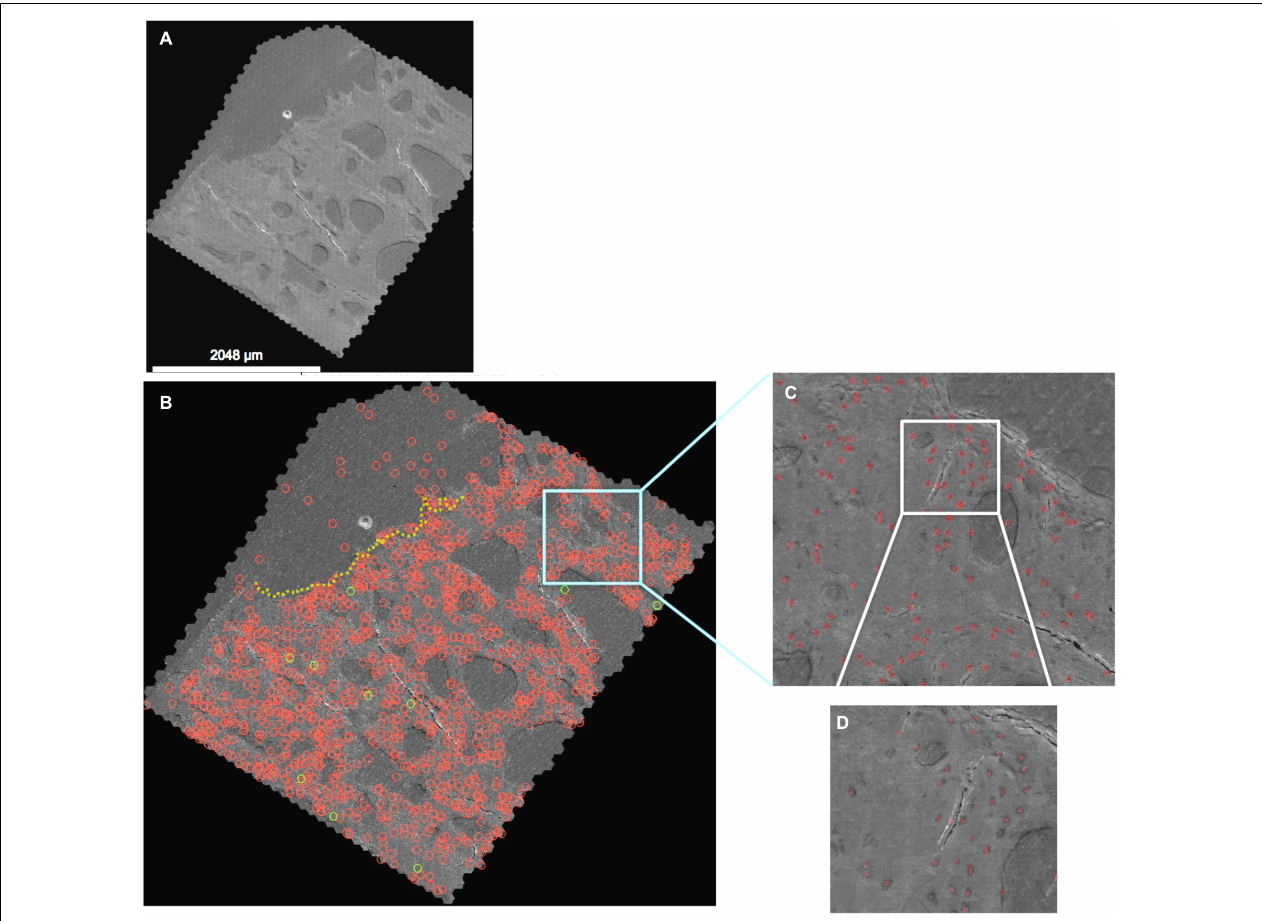
FIGURE 3 | Automated detection algorithm applied to the 2nd generation map (A) , where detections with greater than 70% confidence (quantitative prediction of match to "ground truth" defined by training data) are depicted. (B) The entire map, depicting higher resolution details at increasing levels of zoom (C,D) in the Google Maps API. Note: the red circles indicate detected cells which are changed to green when the classifier (three or more processes) is met. Red circles above the dotted yellow line delineating the edge of the tissue surface ( B , upper corner) are cells, vessels and artifacts outside of the femoral head and neck tissue. The map depicted here can be navigated and explored like Google Maps at http://www.mechbio.org/sites/mechbio/files/maps7/index.html to access the map, type in user: mechbio, password: